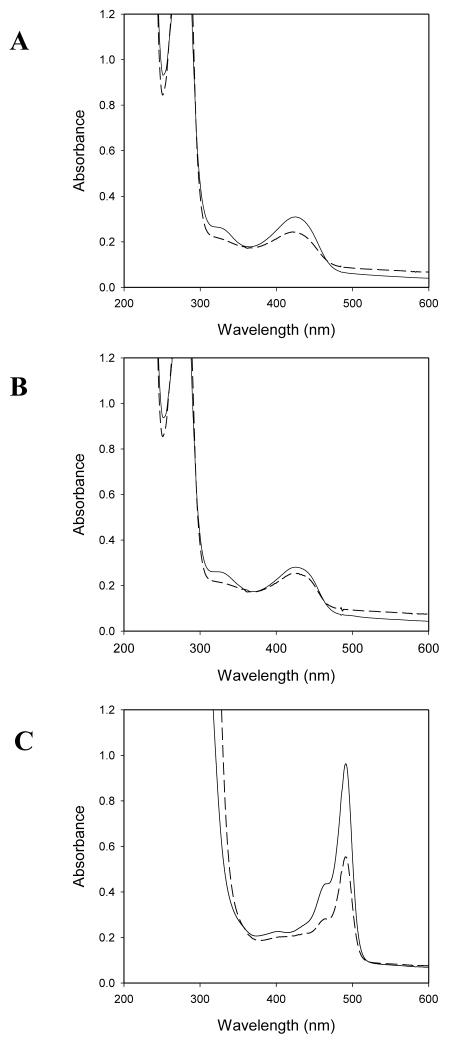
Absorbance spectra of Psychromonas ingrahamii SHMT (piSHMT) and Escherichia coli SHMT (eSHMT) in the absence and presence of substrates. (A) Panel A shows the absorption spectra of 30 μM piSHMT (continuous line), and eSHMT (dashed line) at 30 °C; (B) Panel B shows the absorption spectra after the addition of 90% saturating glycine (continuous line piSHMT and dashed line eSHMT); (C) In panel C are shown the spectra taken after the addition of 100 μM H4PteGlu to the samples containing glycine.